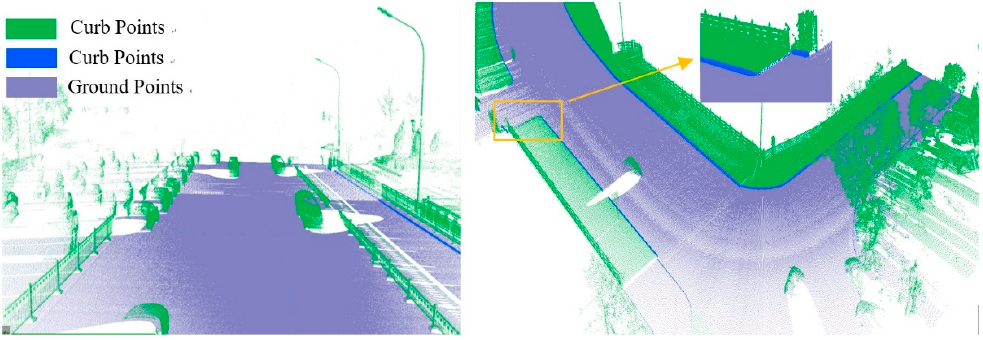
Figure 5. Extraction results for ground and curb points, curb points in blue, ground points in gray, and non-ground points in